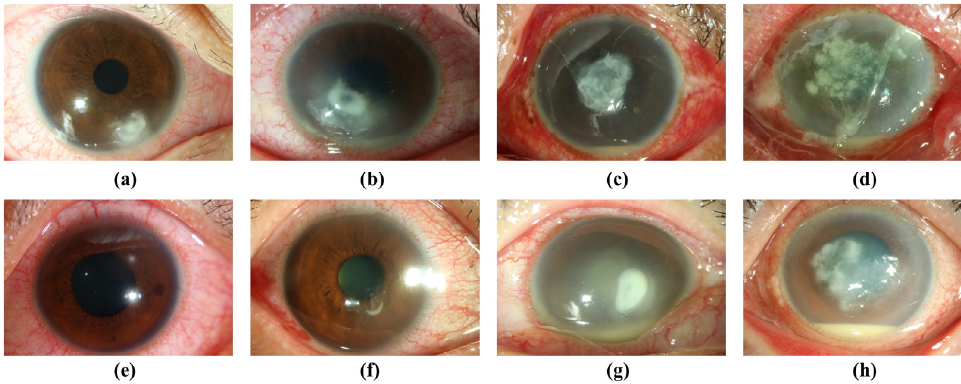
Figure 1. Representative photographs of bacterial keratitis caused by Pseudomonas and non- Pseudomonas spp. ( a – d ) Pseudomonas keratitis; ( e ) Serratia keratitis; ( f ) Staphylococcus keratitis; ( g ) Streptococcus keratitis; ( h ) non-tuberculosis Mycobacterium keratitis.